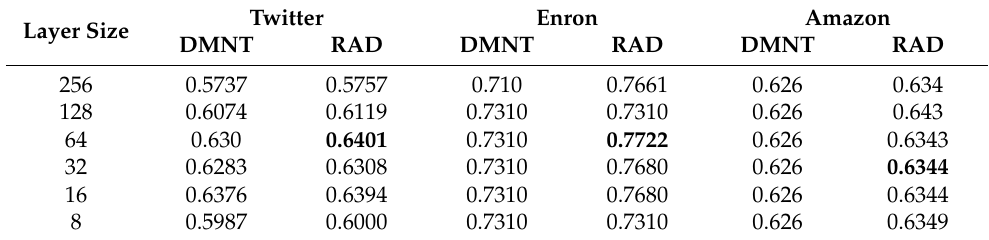
Table 2. AUC scores of NodeAnomEn (proposed ) vs. DOMINANT [18].